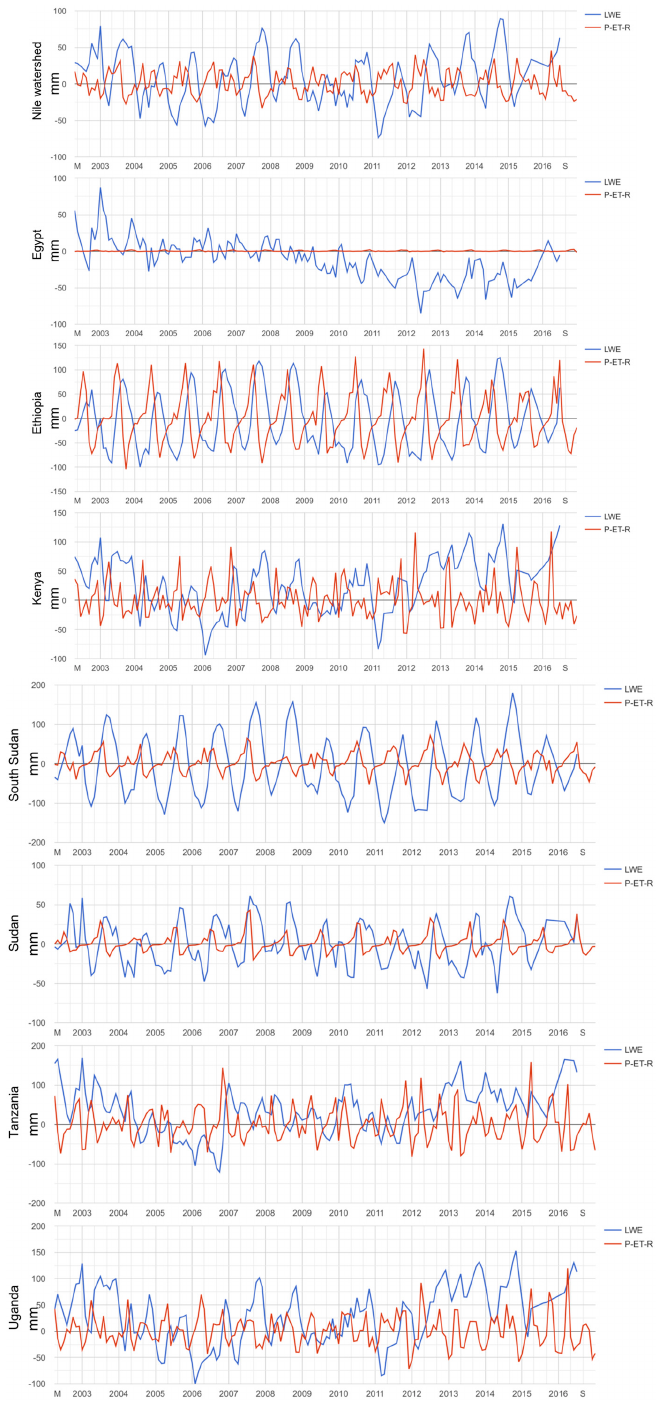
Figure 5. The time series line charts to compare LWE and P-ET-R (precipitation minus ET and runo ff ) over the Nile watershed and the countries (Egypt, Ethiopia, Kenya, South Sudan, Sudan, Tanzania and Uganda) during the period between 2002 and